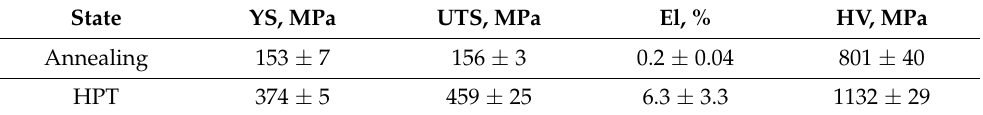
Table 2. The mechanical characteristics of the Zn–1%Mg alloy in the annealed and HPT-treated